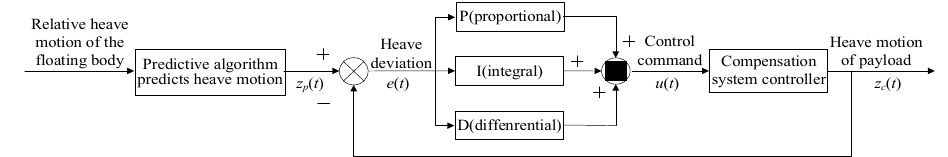
Figure 2. PID predictive control diagram.